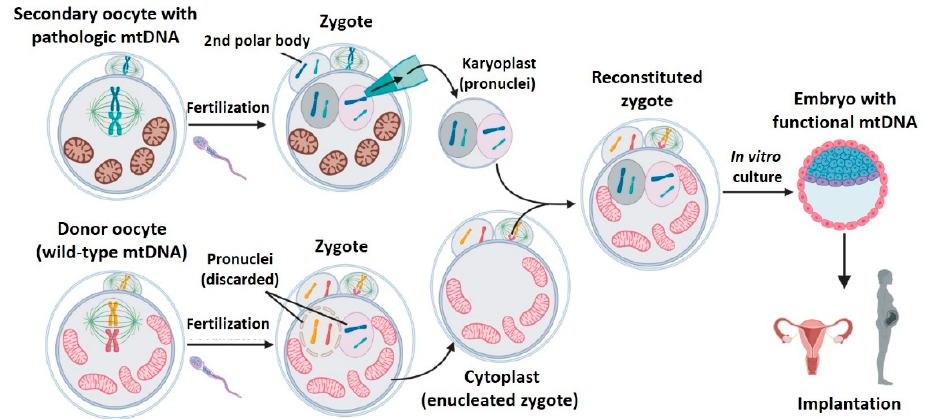
Figure 5. Pronuclear transfer (PNT). During PNT, the pronuclei of a patient’s oocyte is isolated in a karyoplast and transferred into a donor oocyte without its pronucleus. Created with BioRender.com